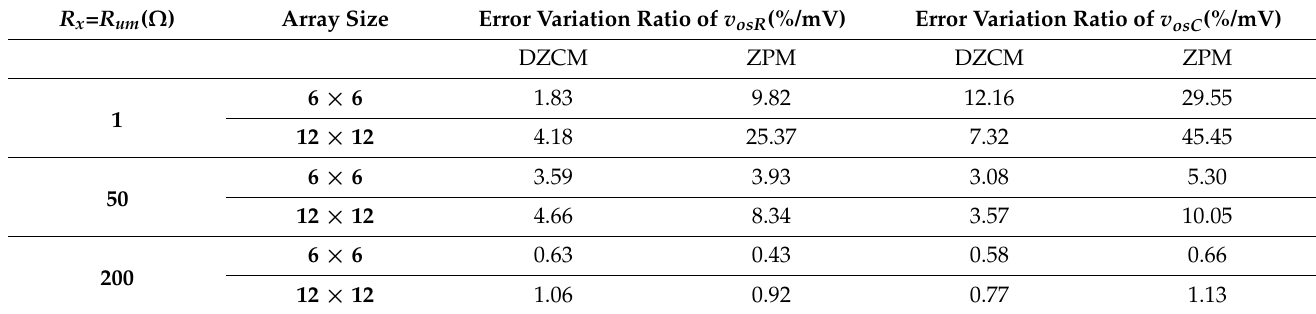
Table 2. R x error variation by v osR , v osC with S AR = 6 × 6, 12 ×